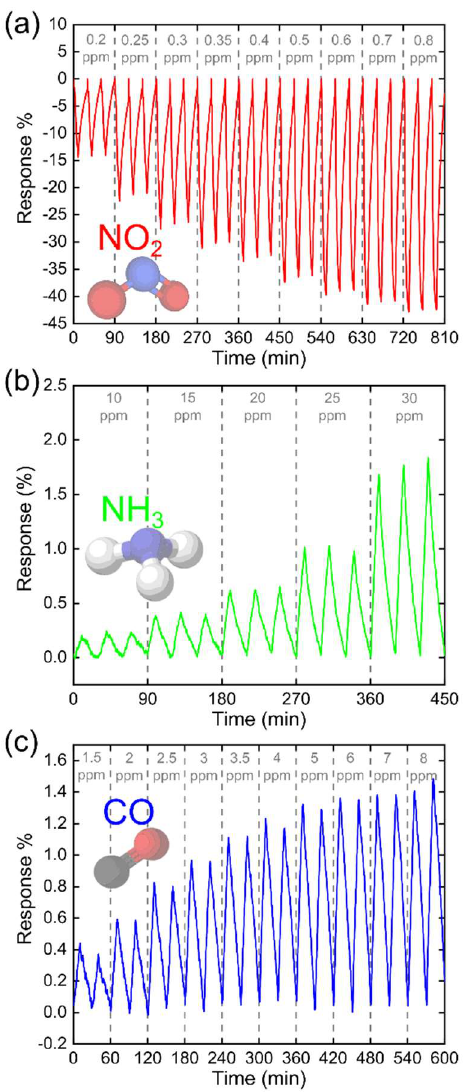
Figure 4. Paper-based sensor response to cyclic exposure to ( a ) NO 2 , ( b ) NH 3 , and ( c ) CO gases.